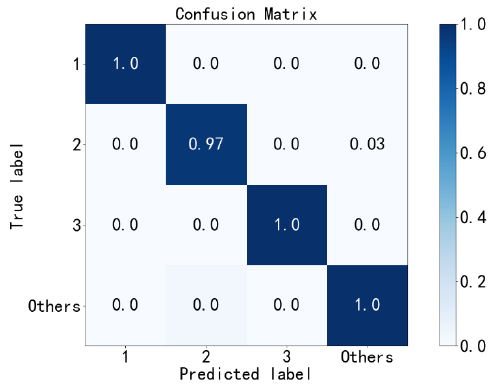
Figure 11. Second fault diagnosis with the PE method. Third, the ORFs with three different fault diameters (labels 4~6) are diagnosed, and remaining fault states are labeled as others. The confusion matrix of the third diagnosis results is shown in Figure 12. It can be seen the accuracy of this fault diagnosis is 99.5%. Then, all diagnosed ORFs are eliminated from the test set.